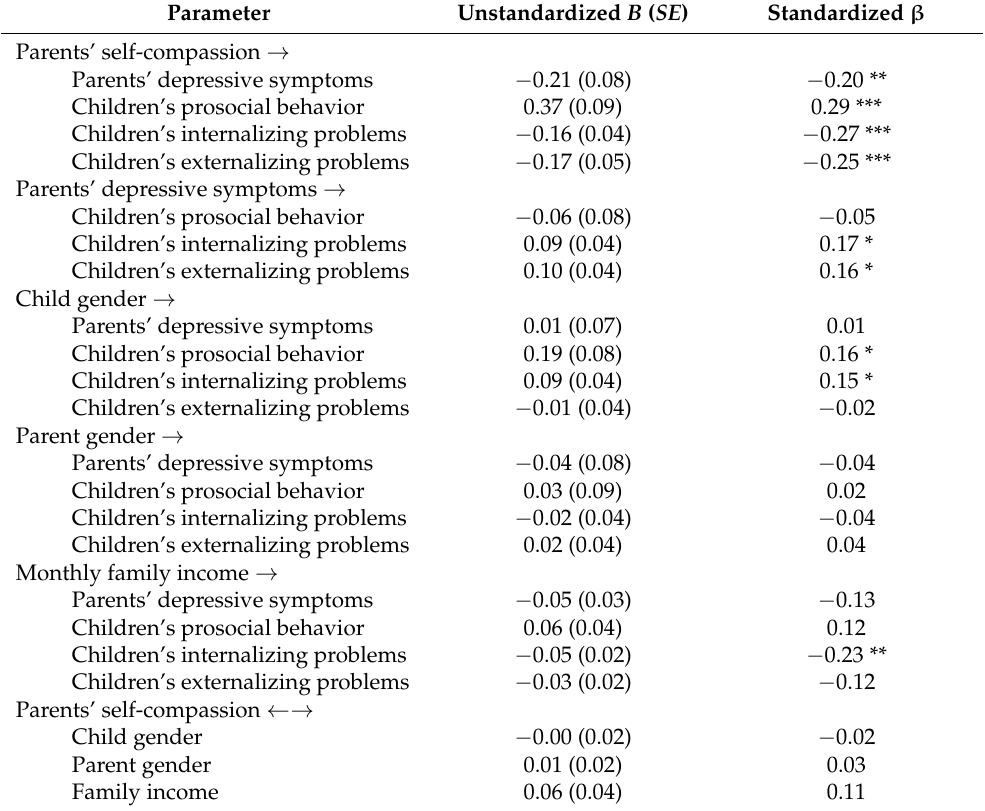
Table 2. Parameter estimates of the model with parents’ depressive symptoms as a mediator.